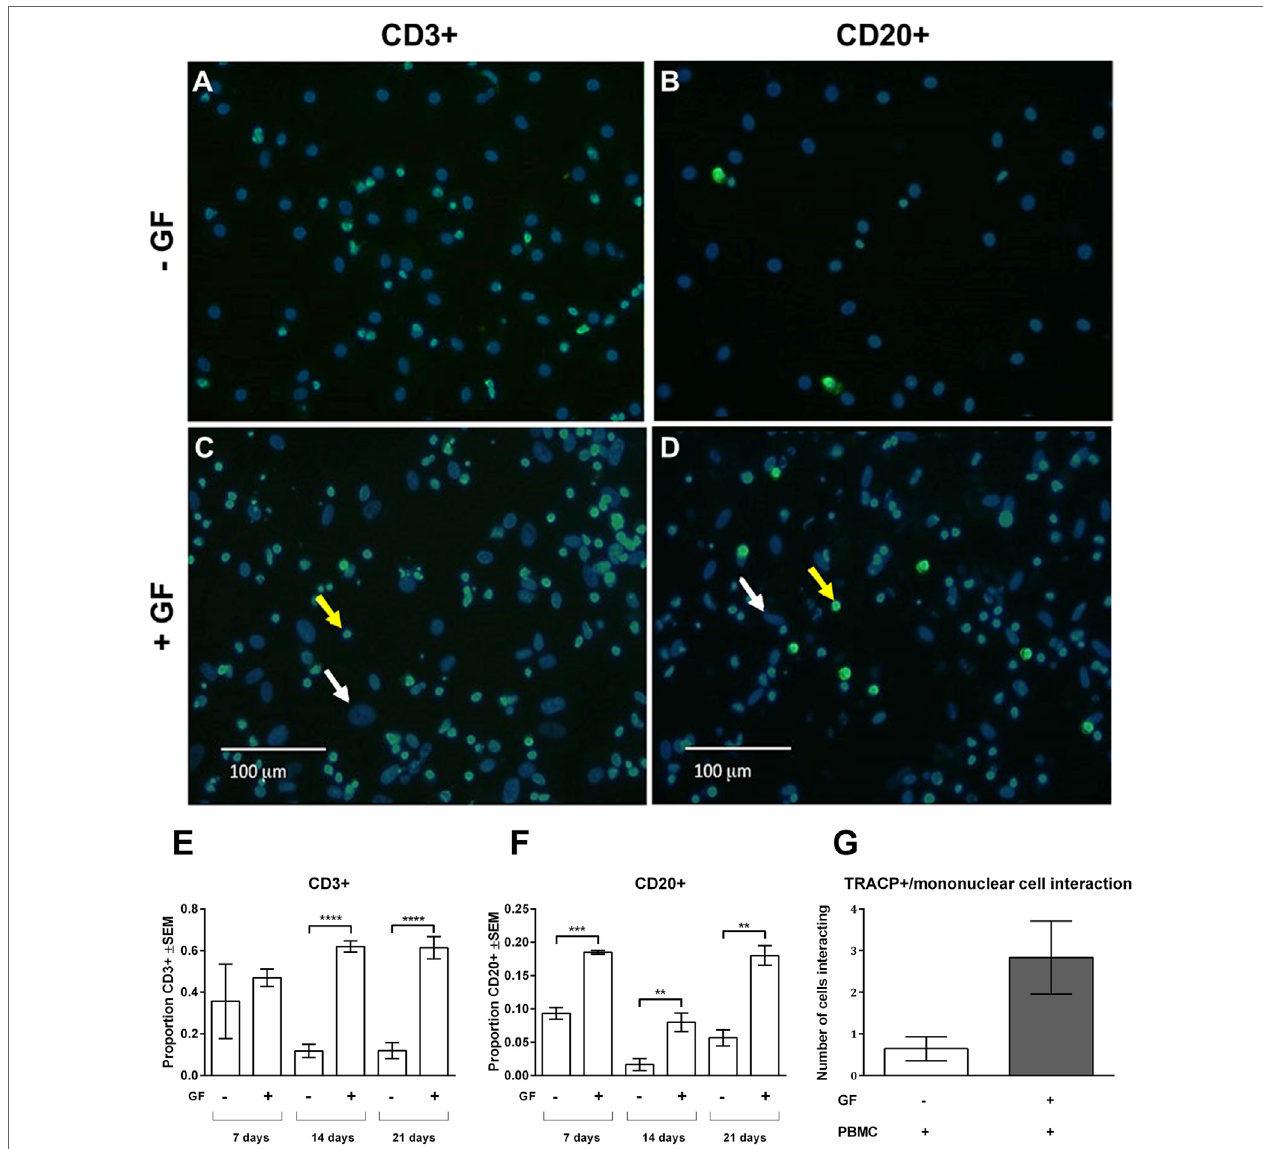
FigUre 3 | Gingival fibroblasts (GFs) are involved in the retention and survival of T and B cells after coculture with peripheral blood mononuclear cells (PBMCs). Overlay of immunohistochemical stainings with 4 ′ ,6-diamidino-2-fenylindool (DAPI) and CD3 + or CD20 + staining of (a,B) monocultures of PBMCs and (c,D) GF cocultures with PBMCs after 21 days of culture. (a,c) CD3 + and (B,D) CD20 + stainings (green) were performed to identify T and B cells, respectively. Nuclei are stained with DAPI (blue). GF nuclei are depicted with white arrows. CD3 + cells (a,c) and CD20 + cells (B,D) are depicted with yellow arrows, which are abundantly present in cocultures with GFs. Micrographs are representatives for two independent experiments with five different GF sources. Scale bars represent 100 µM. Proportions of CD3 + (e) and CD20 + (F) cells of total mononuclear cells after 7, 14, and 21 days were quantified from two standardized pictures per well. Significantly more CD3 + and CD20 + cells were identified in GF cocultures. The number of mononuclear cells interacting with TRACP + cells (g) in PBMC monoculture (white bar) and GF coculture (gray bar). No significant difference ( p = 0.0561) between mono- and cocultures was found. n = 5 GF donors, n = 2